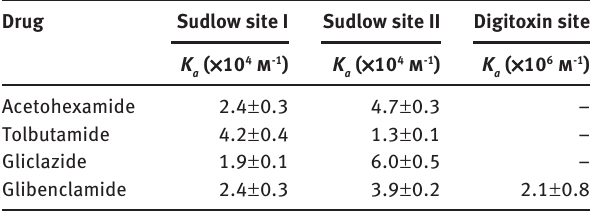
Table 4 Association equilibrium constants ( K lurea drugs at specific binding regions on normal HSA.